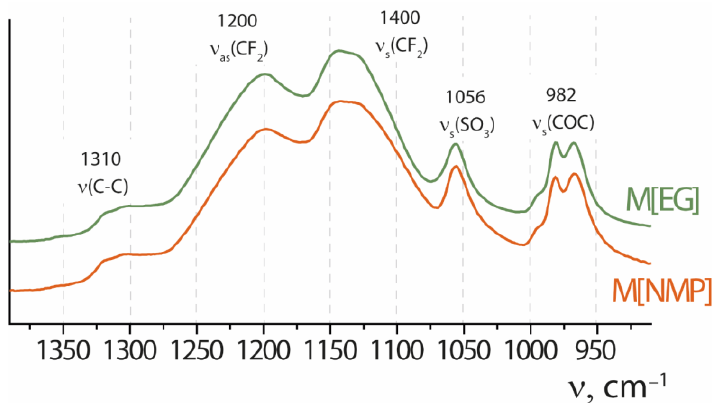
Figure 4. Fragments of IR spectra of some membranes in H + -form: M[DMF] and M[EG]. The samples were pre-dried at 50 °C under vacuum for 24 h.